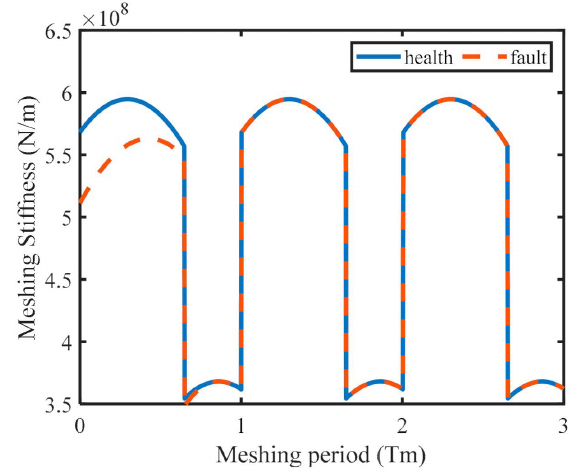
Figure 9. Time-varying gear meshing stiffness of sun-planet.